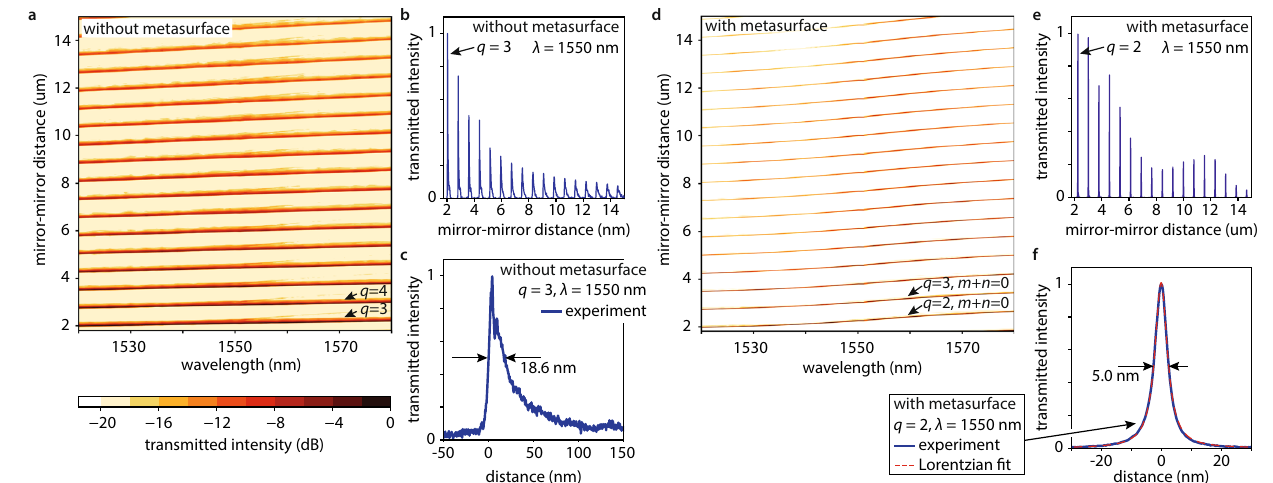
Fig. 3 | Experimental demonstration of a metasurface-stabilized optical microcavity. a measured wavelength- and cavity length-dependent transmission (normalized) of a laser beam focused into an unstabilized Fabry Perot cavity (false color plot). q denotes the longitudinal mode index. b measured cavity length- dependent transmission(normalized) of a laserbeam withwavelength λ =1550 nm focused into an unstabilized Fabry Perot cavity (blue line). c measured cavity length-dependent transmission (normalized) of a laser beam with wavelength λ =1550nmfocusedintoanunstabilizedFabryPerotcavity(blueline)inthevicinity of the resonant length of the longitudinal mode with index q =3 : The black arrows indicate the full width at half maximum (FWHM) of the length tuning bandwidth. d